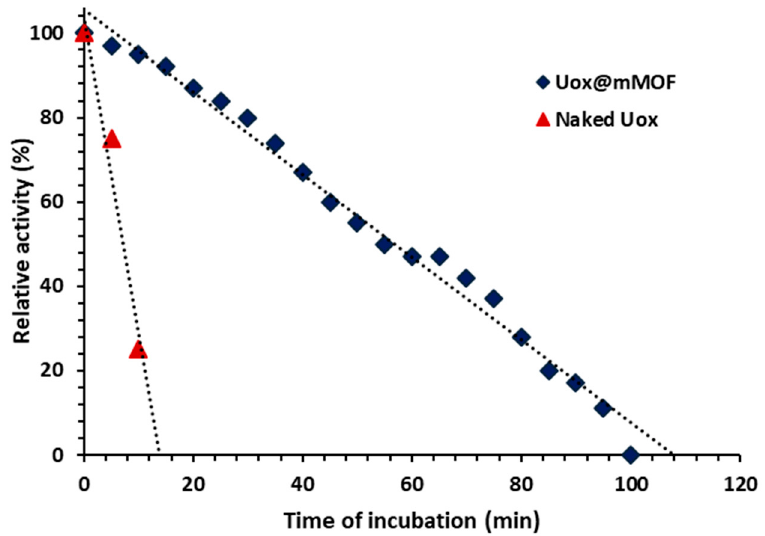
Figure 8. Thermal stability studies of Uox and Uox@mMOF.